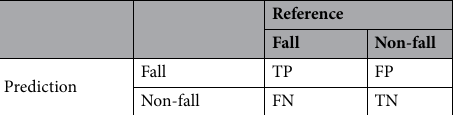
Table 1. The confusion matrix provides a mechanism to assess the accuracy of binary diagnostic